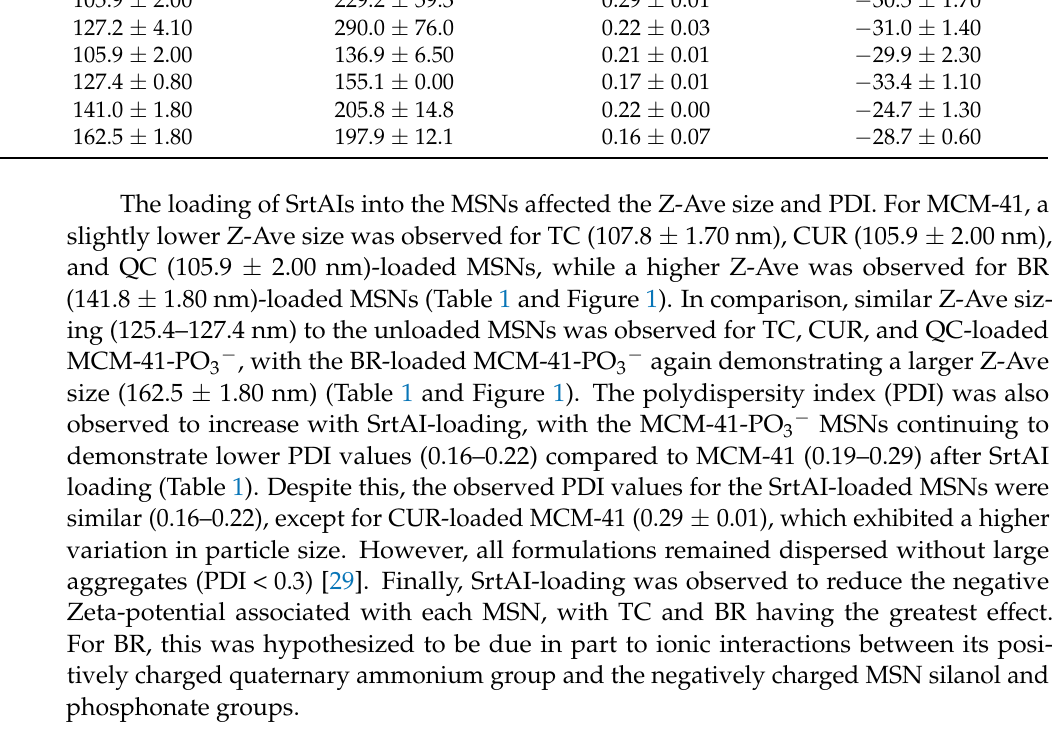
Figure 2. Transmission electron microscopy (TEM) for SrtAIs MCM-41 and MCM-41-PO 3 − . Scale bars represent 100 nm. TGA was used to determine the SrtAI loading capacity of MCM-41 and MCM-41- PO 3 − MSNs by comparing the weight loss associated with temperature ramping (50–900 °C; 25–900 °C for TC-loaded MSNs) between unloaded MSNs, SrtAI-loaded MSNs, and the SrtAIs alone. Using this technique (Figure 3), the loading capacities of TC, CUR, QC, and BR in MCM-41 MSNs were 9.8, 7.6, 9.6, and 8.7% ( w / w ), respectively, and 9.2, 9.3, 8.5, and 6.2% ( w / w ) in MCM-41-PO 3 − MSNs, respectively. The theoretical MSN loading capac- ity for each SrtAI was 10% ( w / w ), based on the rotary evaporation formulation method, where 10 mg of each individual SrtAI was added to 90 mg of each MSN. Thus, these data suggest that the MSNs were efficiently loaded with SrtAIs. In addition, similar SrtAI load- ing capacities were measured between the MCM-41 and MCM-41-PO 3 − MSNs, except for BR, which demonstrated a 29% lower loading capacity with MCM-41-PO 3 − compared to